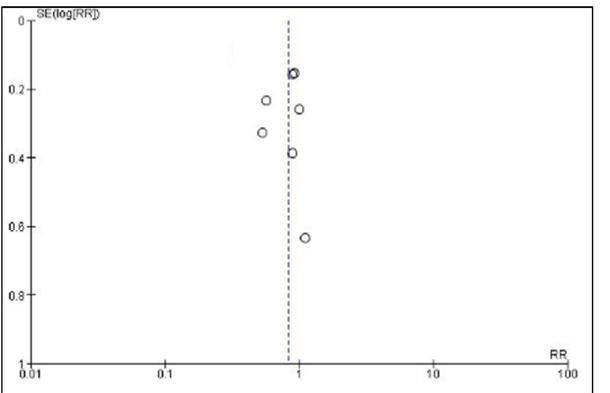
Fig 5. Assessment of Publication Bias. Assessment of potential publication bias among included trials via funnel